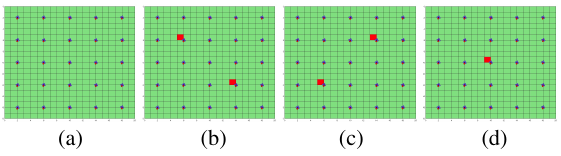
Figure 5. Requirements: iterations 0-1999, (a) none, (b) 2000-3999, (c) 4000-5999, (d) 6000-7999 and (b)